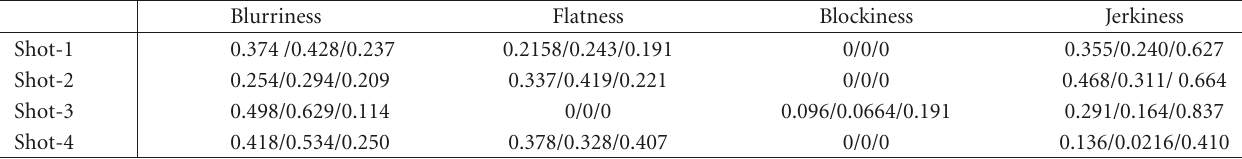
Table 3: The normalized coe ffi cients of the cost function for all users, type-A users, and type-B users, respectively.